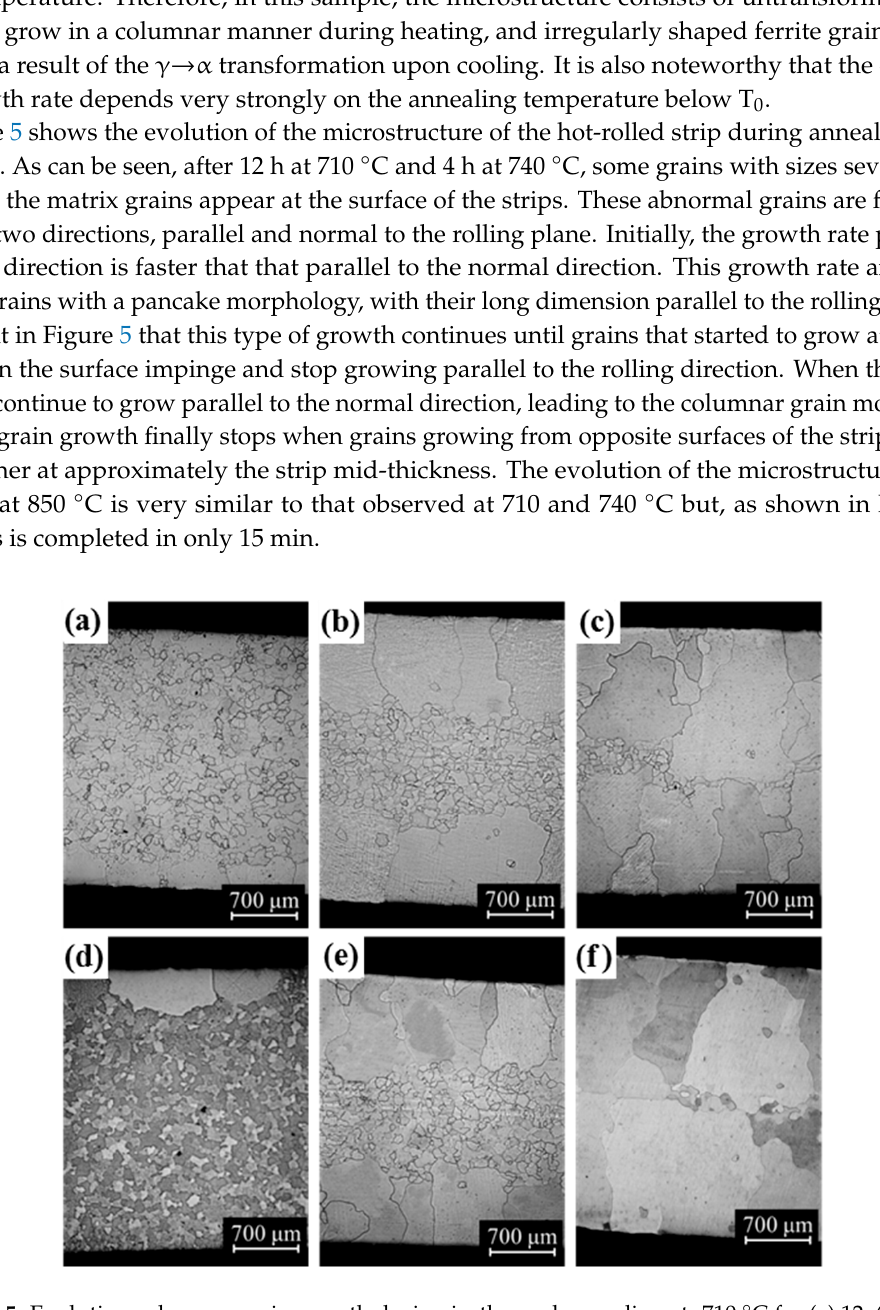
Figure 5. Evolution columnar grain growth during isothermal annealing at: 710 °C for ( a ) 12, ( b ) 48 and ( c ) 72 h and 740 °C for ( d ) 4, ( e ) 14 and ( f ) 24 h. Micrographs were taken through the thickness of the strips.